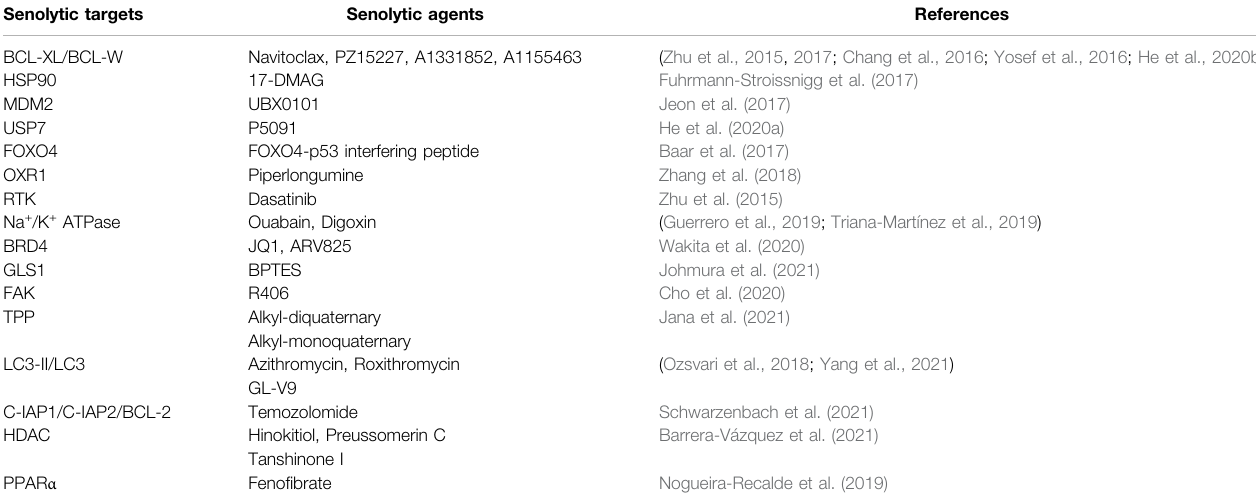
TABLE 1 | Senolytic targets and